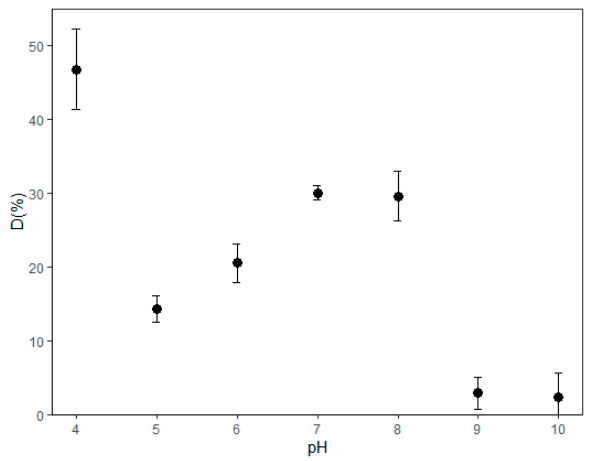
ff erent levels of